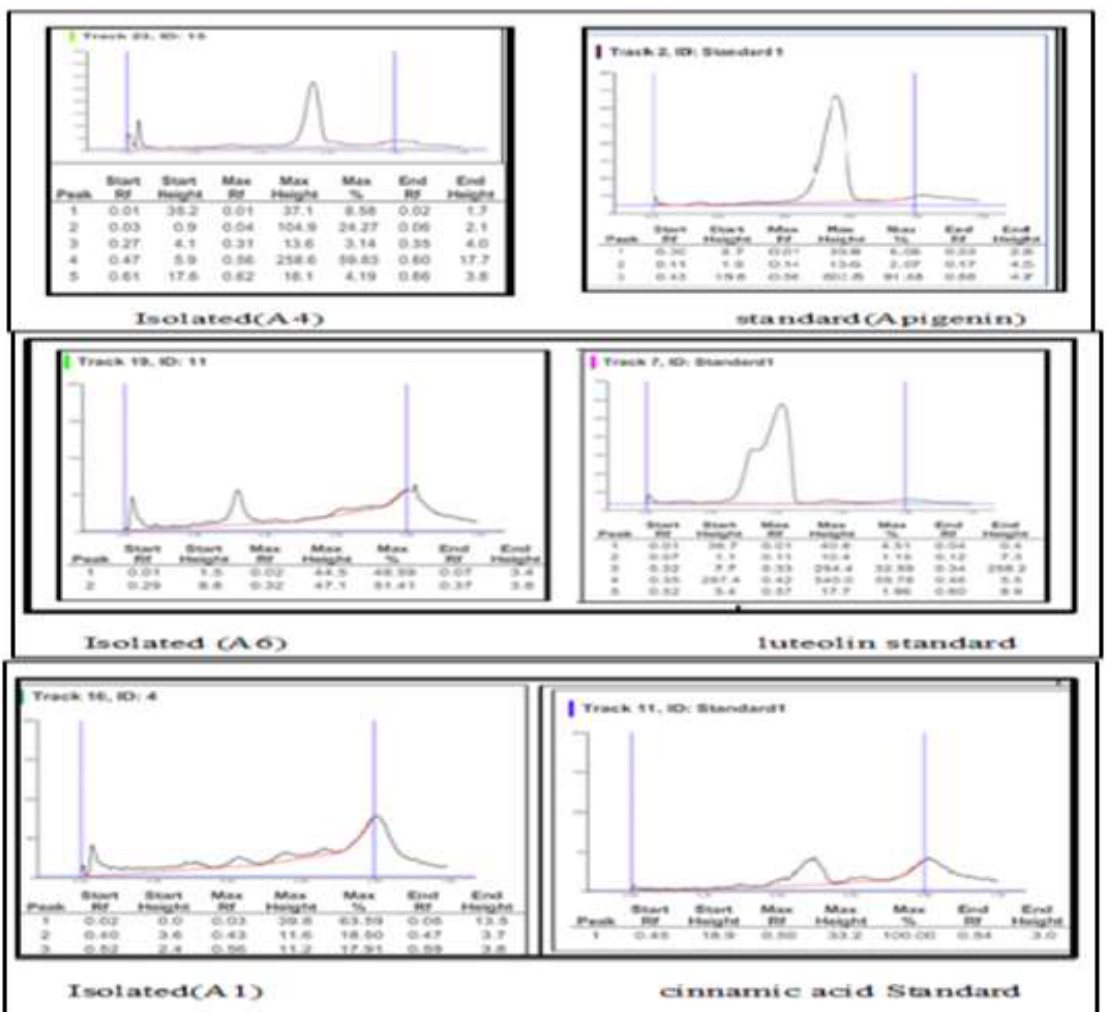
Figure4. HPTLC for isolated (A4)(1) standard(apigenin),(A6)(3) and standard( luteolin) and (A1) and and standard(cinnamic acid).